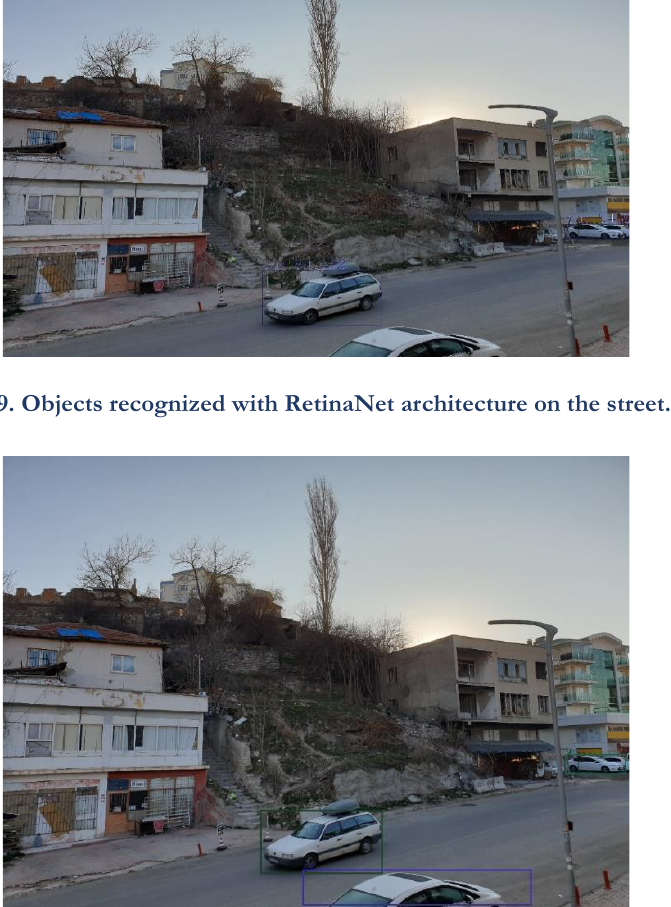
Fig. 20. Objects recognized with YOLOv3 architecture on the street.